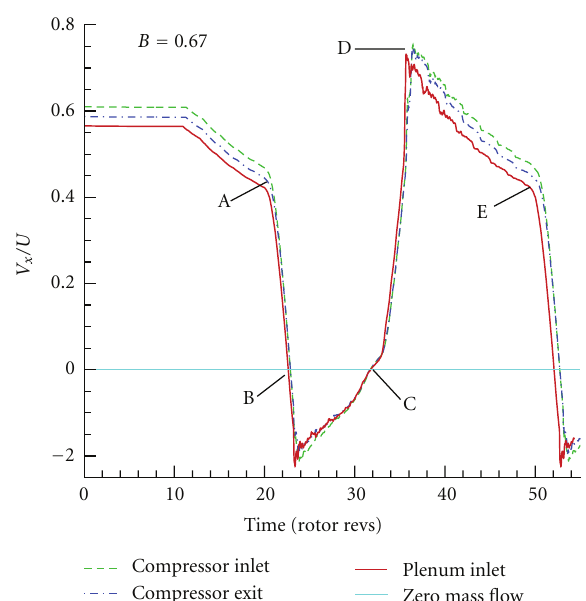
Figure 8: Numerical mass flow coe ffi cients at di ff erent locations.